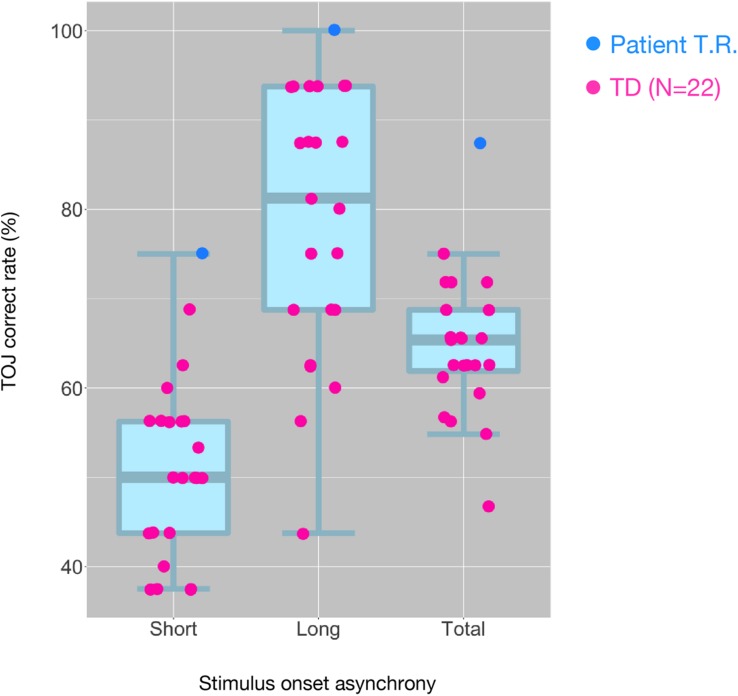
Distribution of tactile temporal order judgment (TOJ) performance of all subjects inside the MRI scanner. The box and whisker plots with the superimposed data points show the distribution of correct TOJ rates of the subjects in the “Short SOA,” “Long SOA,” and “Total (Short SOA + Long SOA)” conditions, respectively. Each box and whisker plot show the 10th, 25th, 50th, 75th, and 90th percentiles of the data. Each filled circle represents correct rate calculated from 32 trials in patient T.R. (blue) and TD controls (magenta). SOA, stimulus onset asynchrony.